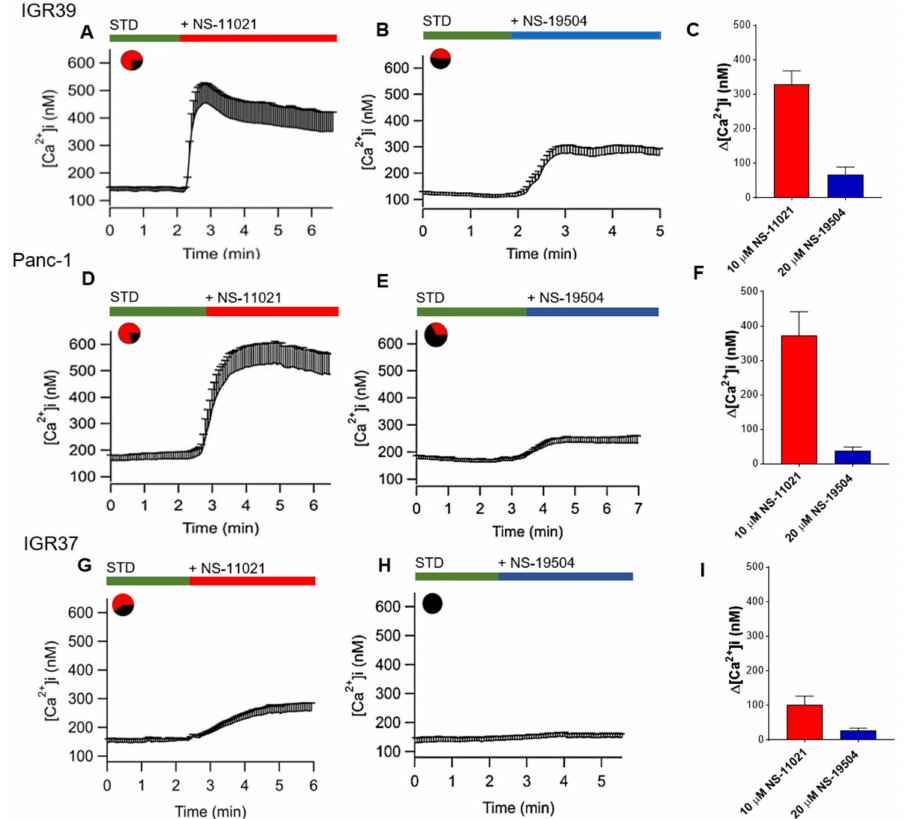
Figure 8. Effects of NS-11021 and NS-19504 on intracellular calcium. Average [Ca 2+ ] i signal in IGR39 and Panc-1 cells after the application of 10 µ M NS-11021 or 20 µ M NS-19054. Horizontal bars indicate the time period of exposure. Average traces were obtained from n = 53 cells (( A ), IGR39), n = 57 cells (( D ), Panc-1), and n = 33 cells (( G ), IGR37) for NS-11021; n = 49 cells (( B ), IGR39), n = 52 cells (( E ), Panc-1), n = 32 cells (( H ), IGR37) for NS-19504 in at least 5 independent experiments. Pie charts indicate the percentage of responsive cells (75% in IGR39, 79% in Panc-1, 54% in IGR37 for NS-11021, and 48% in IGR39, 33% in Panc-1 for NS-19054). Histogram ( C , F , I ) of mean data ± SE for both cell lines. IGR39: 328 ± 72 nM, 168 ± 33 nM; Panc-1: 372 ± 80 nM, 75 ± 21 nM; IGR37: 110 ± 22 nM, 14 ± 12 nM for NS-11021 and